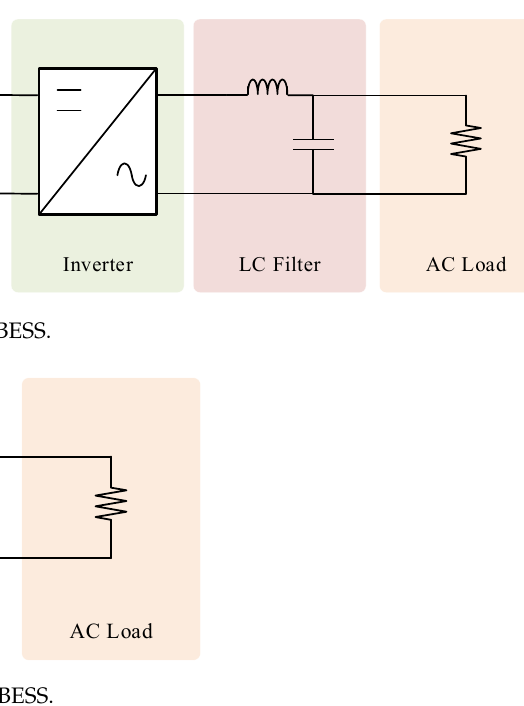
Figure 4. The single-stage topology of a BESS.